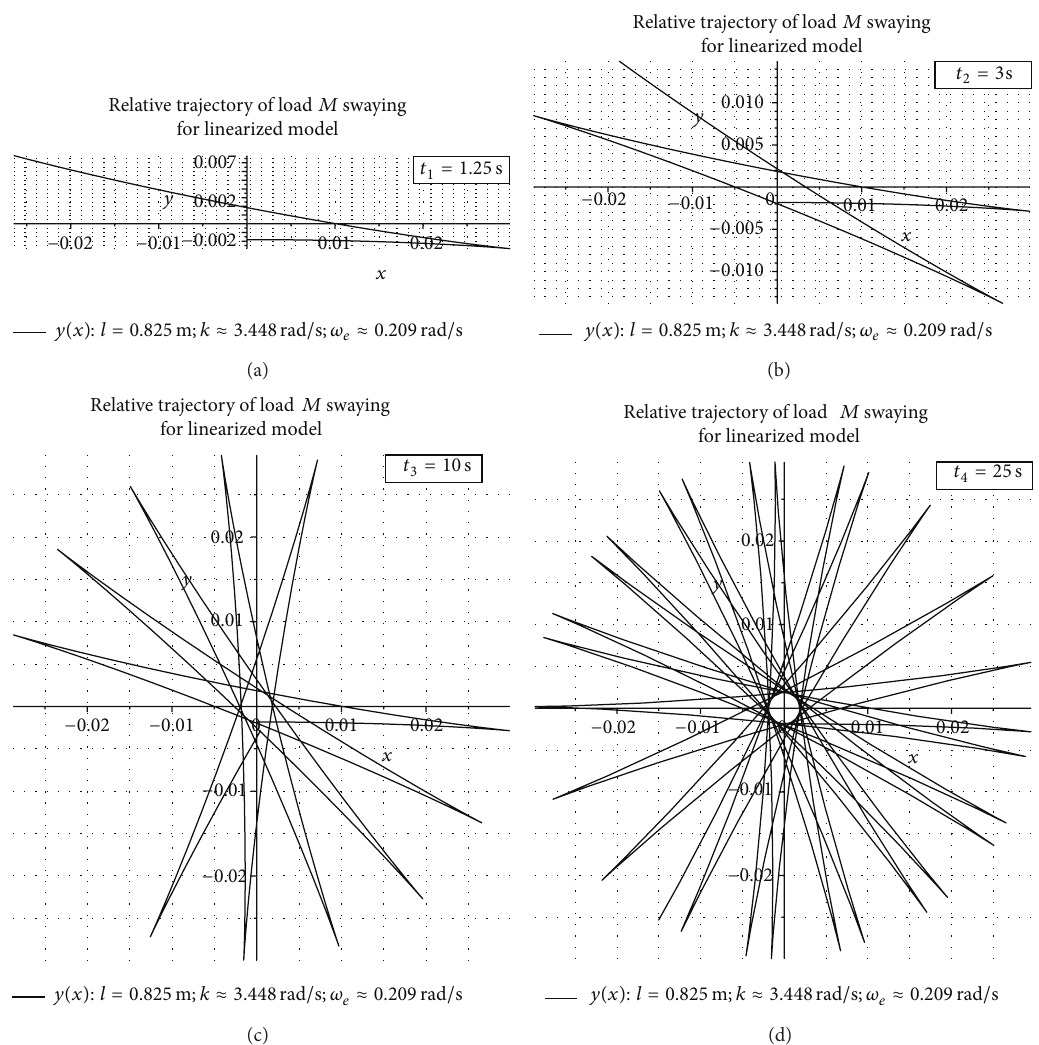
Figure 12: The relative trajectories for load 𝑀 swaying on the cable during uniform rotational motion of the crane boom 𝐵𝑂 2 for the moments of times 𝑡 1 = 1.25 s (a), 𝑡 2 = 3 s (b), 𝑡 3 = 10 s, (c) and 𝑡 4 = 25 s (d), derived with linearized model